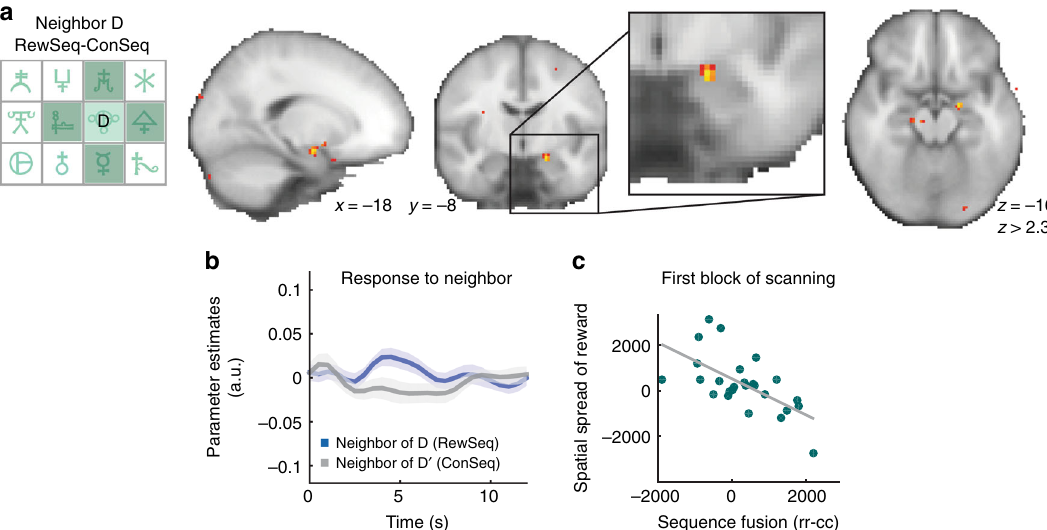
Fig. 5 Spatial spread of reward effects in amygdala. a Probing differences in the BOLD signal for neighbors of the rewarded goal element D and neighbors of the control sequence element D ′ , i.e. the fi nal elements of the equally frequent RewSeq and ConSeq, showed increased activation for the neighbors of D in centromedial amygdala (3-mm spherical ROI centered on previous coordinate from Jocham et al. 38 ; amygdala is the largest peak at the whole-brain). This is consistent with a mechanism that spreads reward to nearby locations (spatial spread), and thus similar to a previously reported amygdala signature related to a temporal spread of reward. b Average time-series to neighbors of D and D ′ illustrate this effect. c People with more spreading of reward in space (effect in a and b ) show a more pronounced representation of sequence knowledge in central amygdala (more negative means more pronounced cross-stimulus suppression; see Fig. 2) but this relationship is only present in the fi rst block of scanning, i.e., when the information from the learning task is likely to be represented most strongly and before transitions and reward locations are scrambled in the scan task. Error bars denote